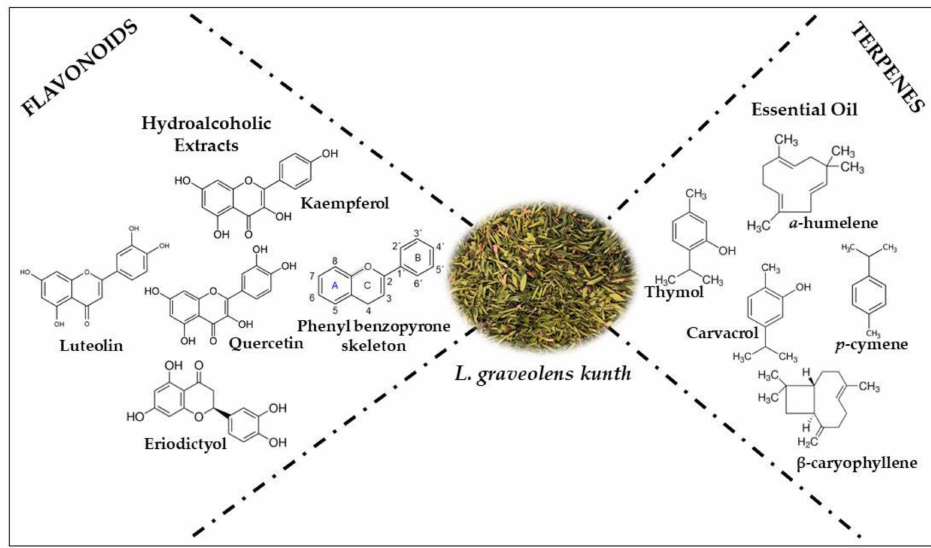
Figure 1. Chemical compounds present in L. graveolens Kunth crops